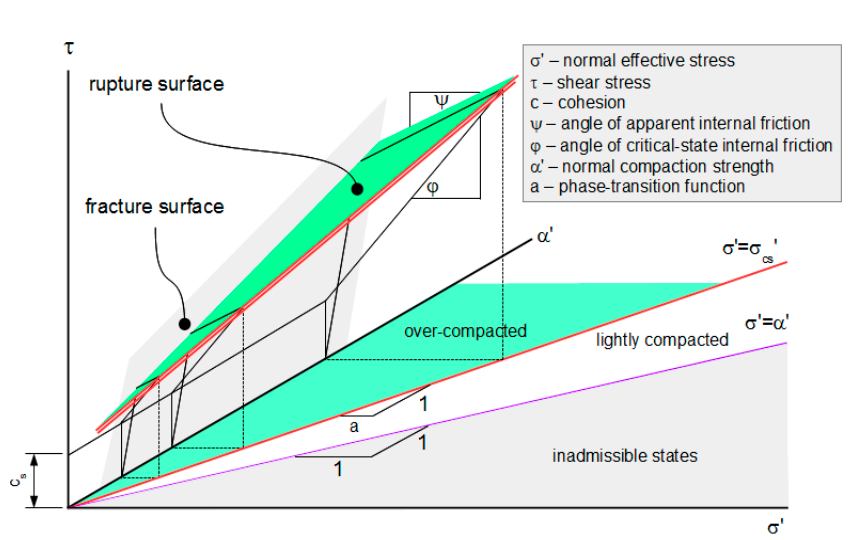
Figure 8. Rupture surface for shearing mode ω = 1/2 and coherence threshold α 0 ’ = 0.